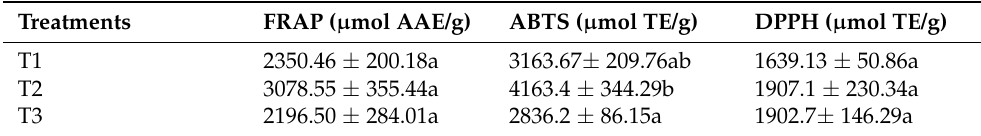
Table 5. Mean ± SE of FRAP ( µ mol AAE/g), ABTS ( µ mol TE/g), and DPPH ( µ mol TE/g) contents of leaves of H. odoratissimum grown using different cultivation